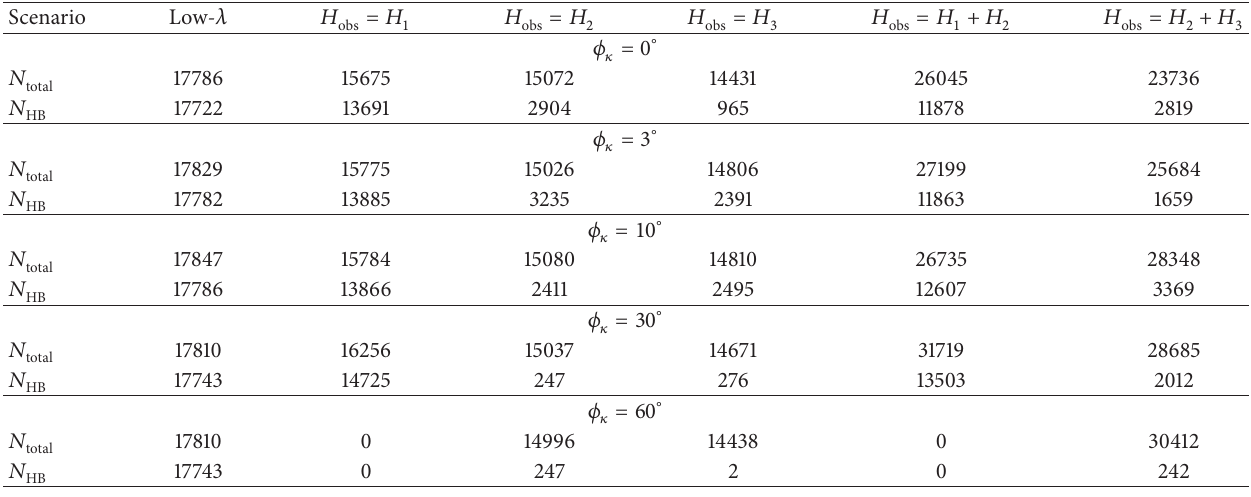
and those passing the HiggsBounds test, for each obs